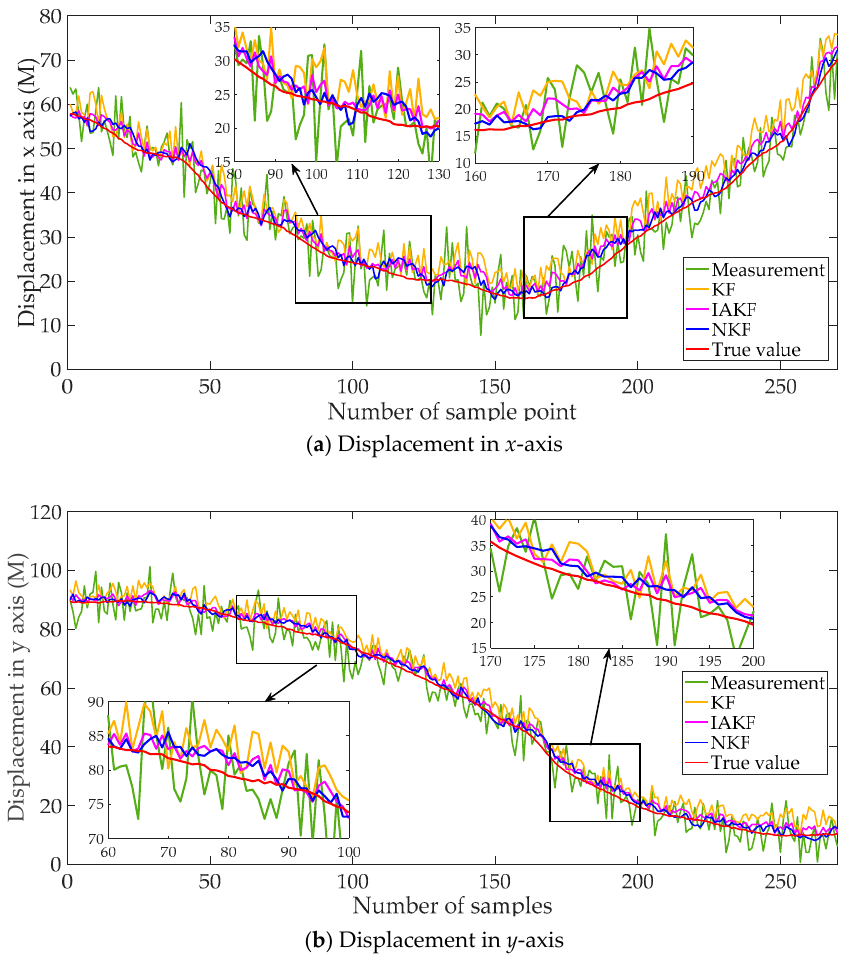
Figure 13. Filtering results of the selected segment of the trajectory. Table 3. Evaluation of filtering errors (segment of the